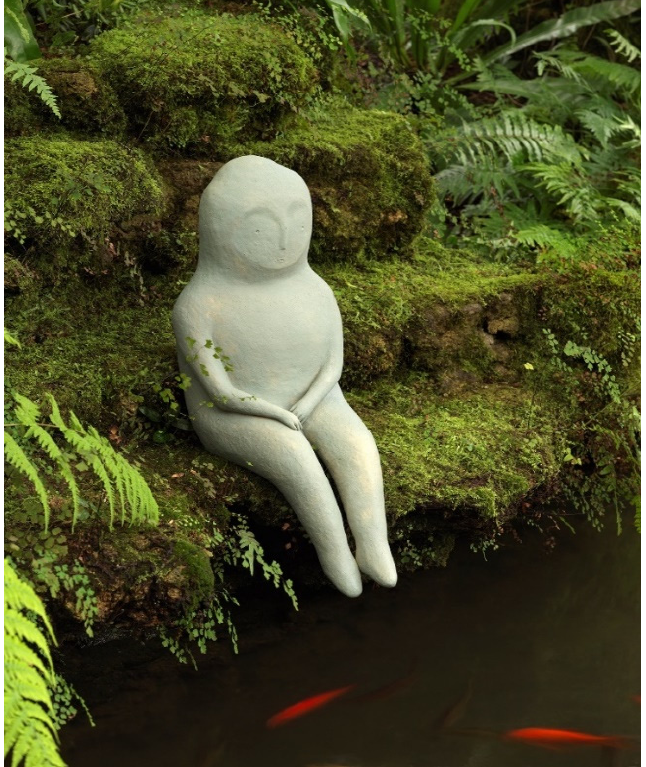
Figure 4. A Genius of the Spot II, 2020, glazed ceramic, 29 ″ × 12 ″ × 14 ″ .